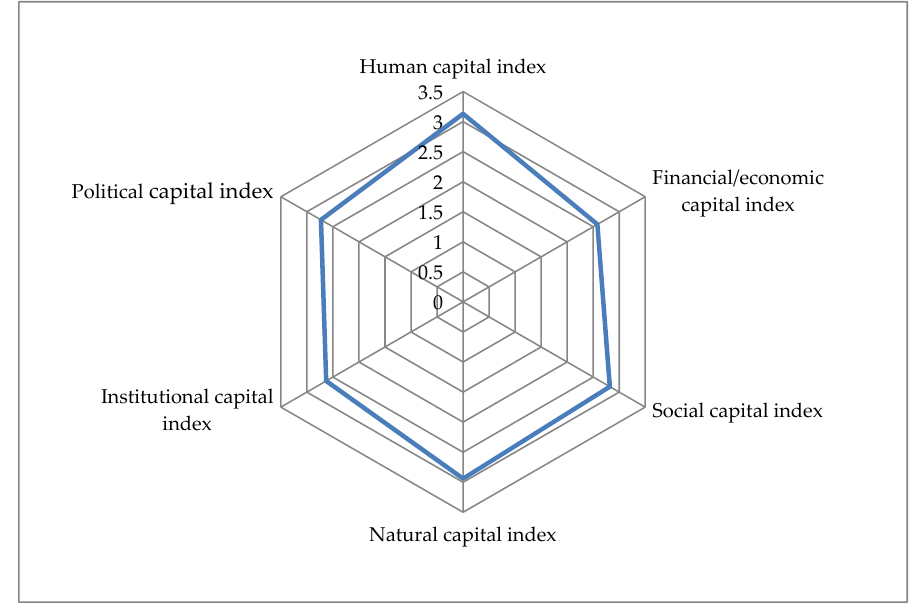
Figure 3. Vulnerability spider diagram of respondents’ livelihood assets / capitals. Source: authors’ calculation.